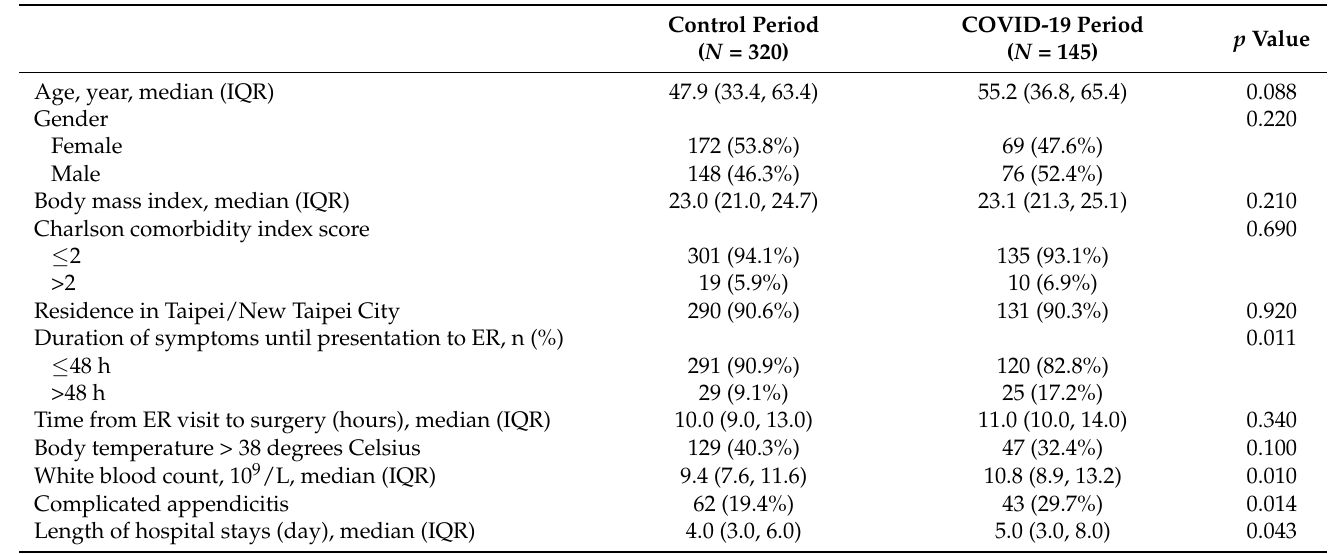
Table 2. Comparison of clinical characteristics between adult patients with acute appendicitis during the COVID-19 epidemic period and the preceding 3-year control period.